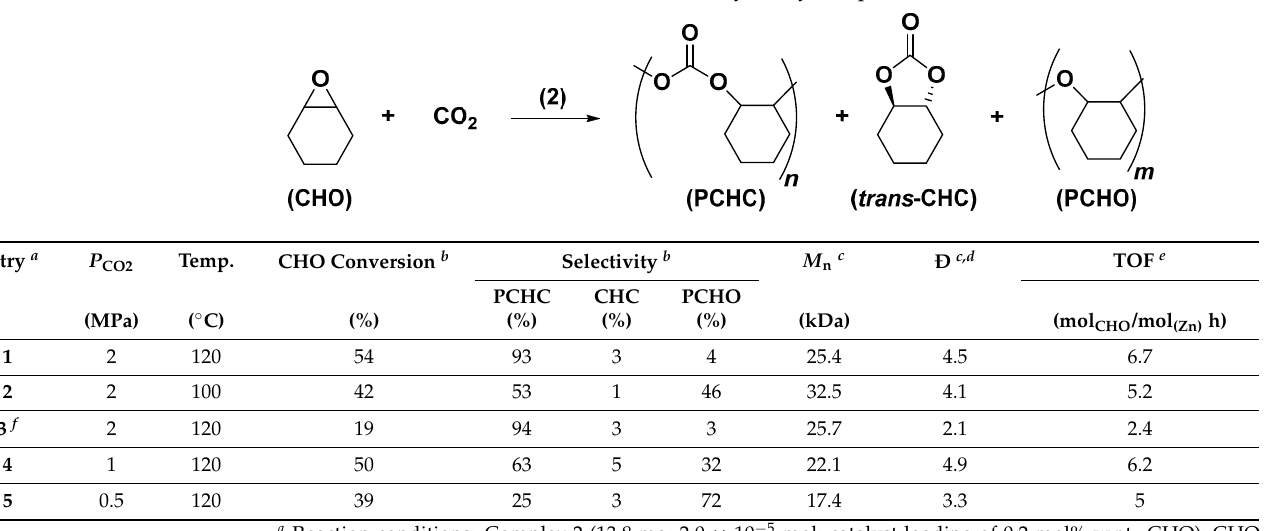
Figure 5. DOSY 1 H NMR spectra (600 MHz, 1,1,2,2-tetrachloroethane- d 2 , 25 °C) of complex 1 ( a ) and complex 2 ( b ). Table 3. ROCOP between CO 2 and CHO catalysed by complex 2 .